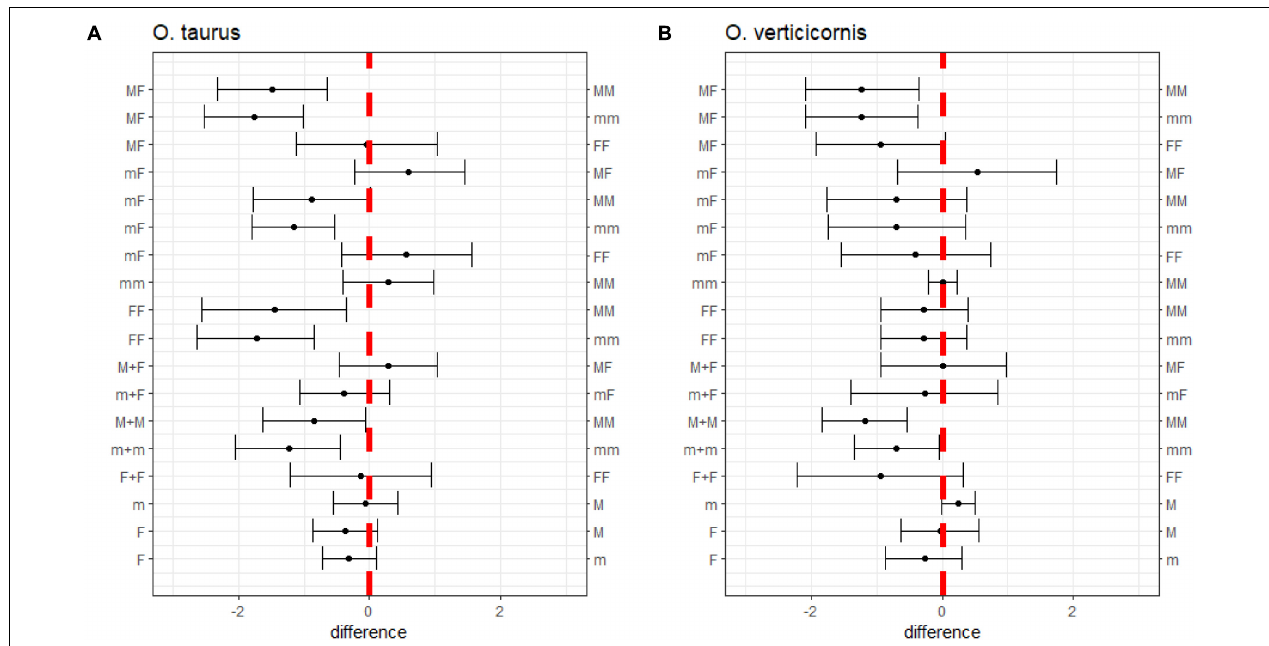
FIGURE 2 | Differences in dung removal among treatments for (A) O. taurus and (B) O. verticicornis . Each bar represents the 95% CI of the difference between the treatments reported on the left and right axis. The comparisons whose bar encloses 0 are not significantly